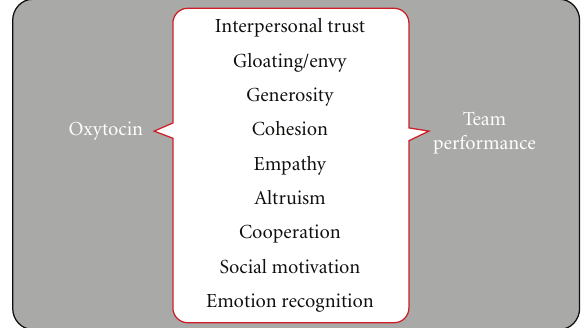
Figure 2: Oxytocin encourages important team